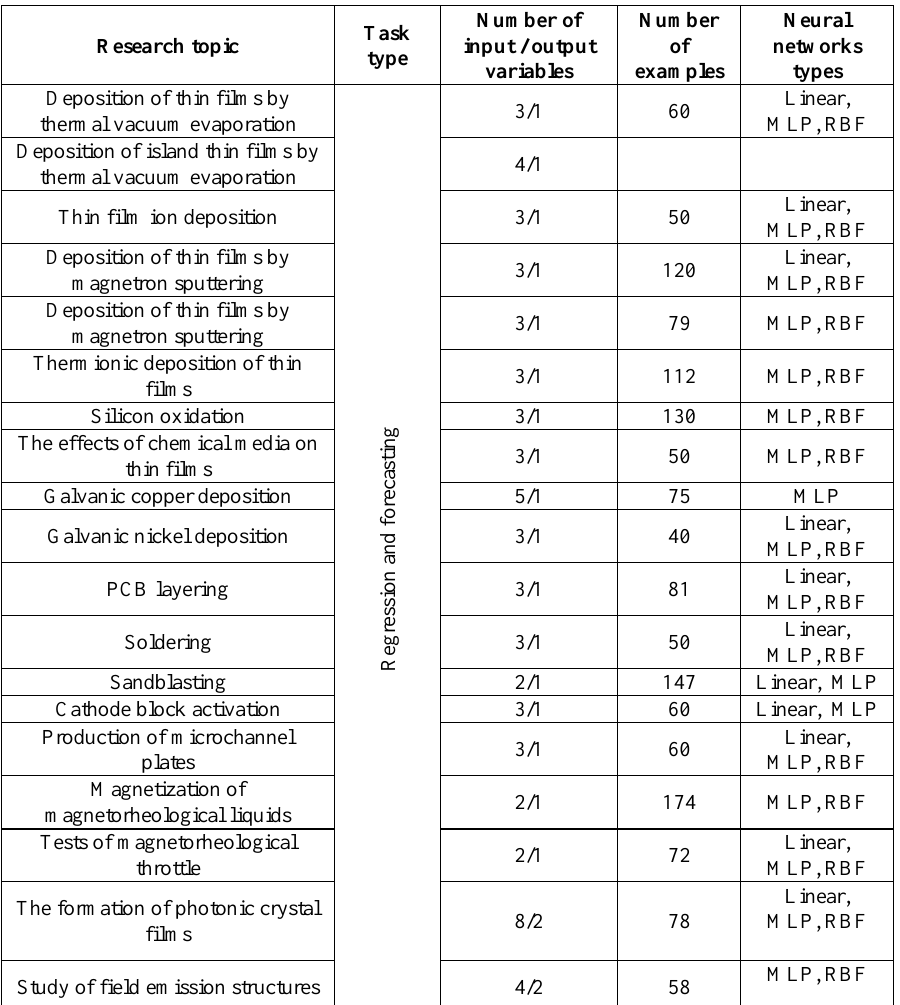
Table 1. Homework Summary for